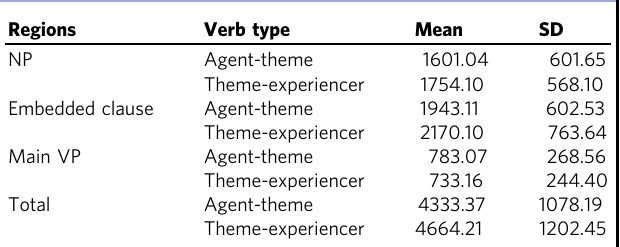
Table 5 Means and SD for ORC with an animate head containing two verb types.